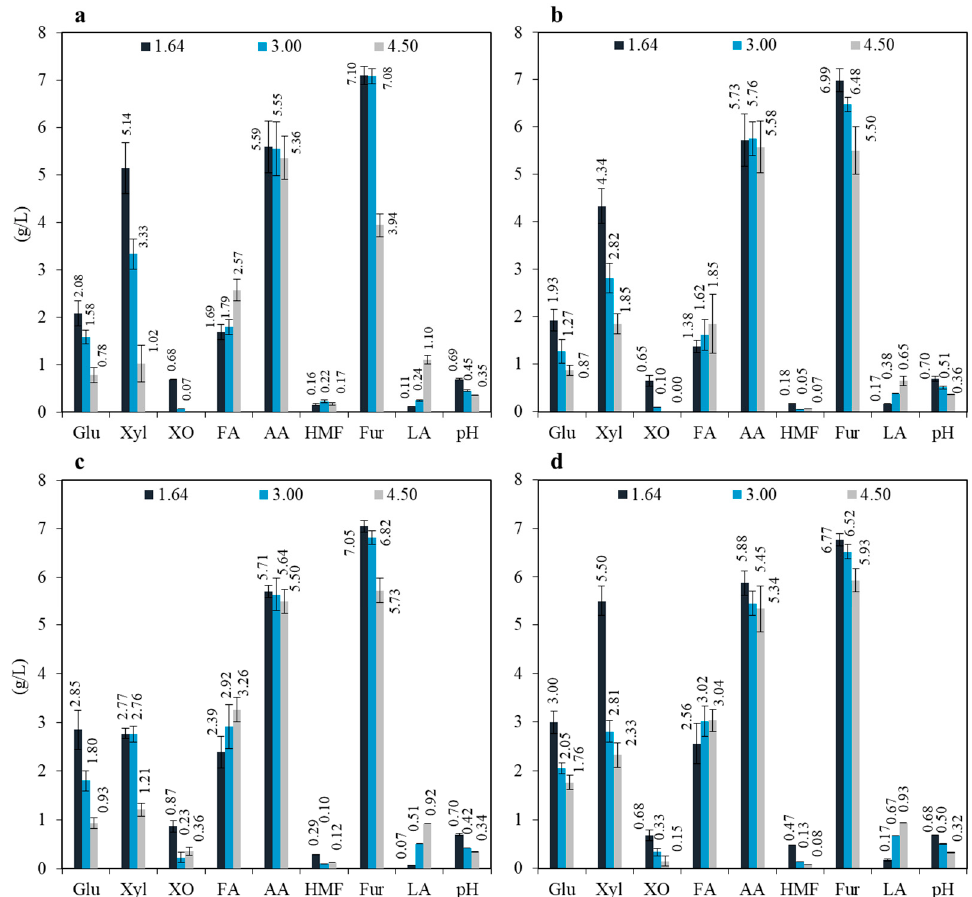
Figure 4. Sugars, xylo-oligomer, and degradation products in second hydrolysates, depending on H 2 SO 4 concentrations (Glu: Glucose, Xyl: Xylose, XO: Xylo-oligomer, FA: Formic acid, AA: Acetic acid, HMF: 5-Hydroxymethylfurfural, Fur: Furfural, LA: levulinic acid, ( a ) CSF 1.89, ( b ) CSF 1.92, ( c ) CSF 2.08, ( d ) CSF: 2.29).